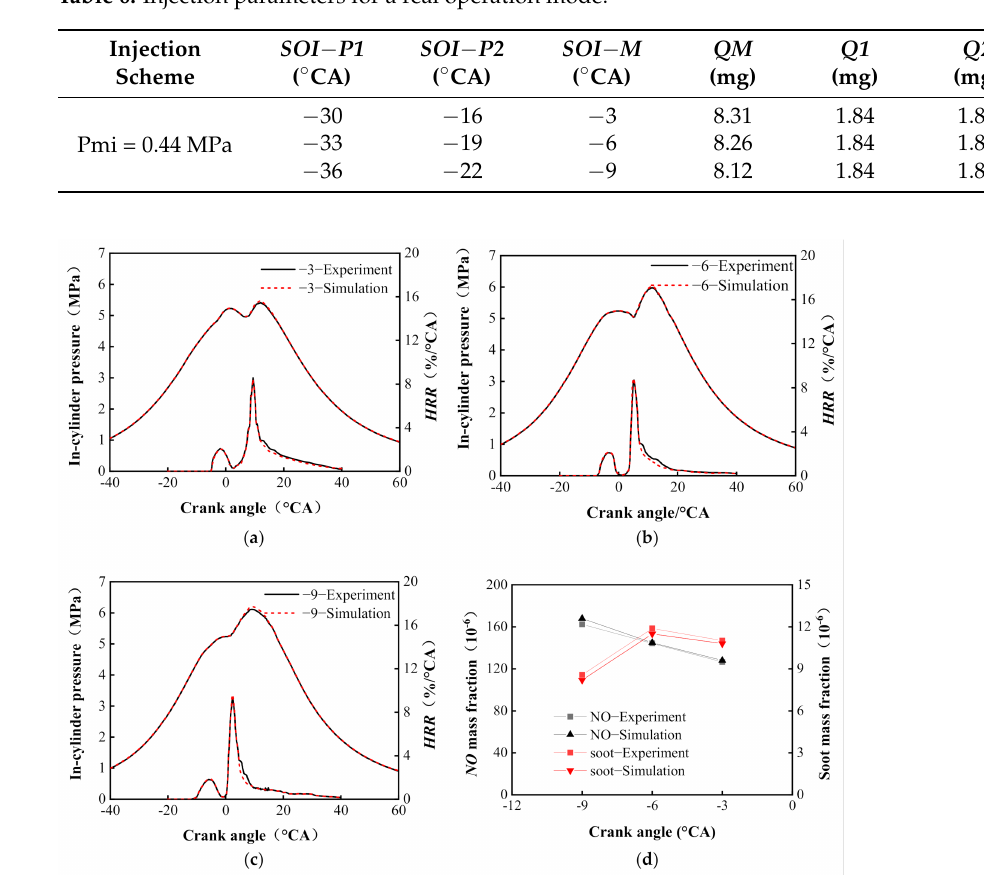
Figure 4. Validation of the simulated and experimental values of cylinder pressure, heat release rate ( HRR ), NO, and soot: ( a ) SOI − M = − 3 ◦ CA; ( b ) SOI − M = − 6 ◦ CA; ( c ) SOI − M = − 9 ◦ CA; ( d ) NO and